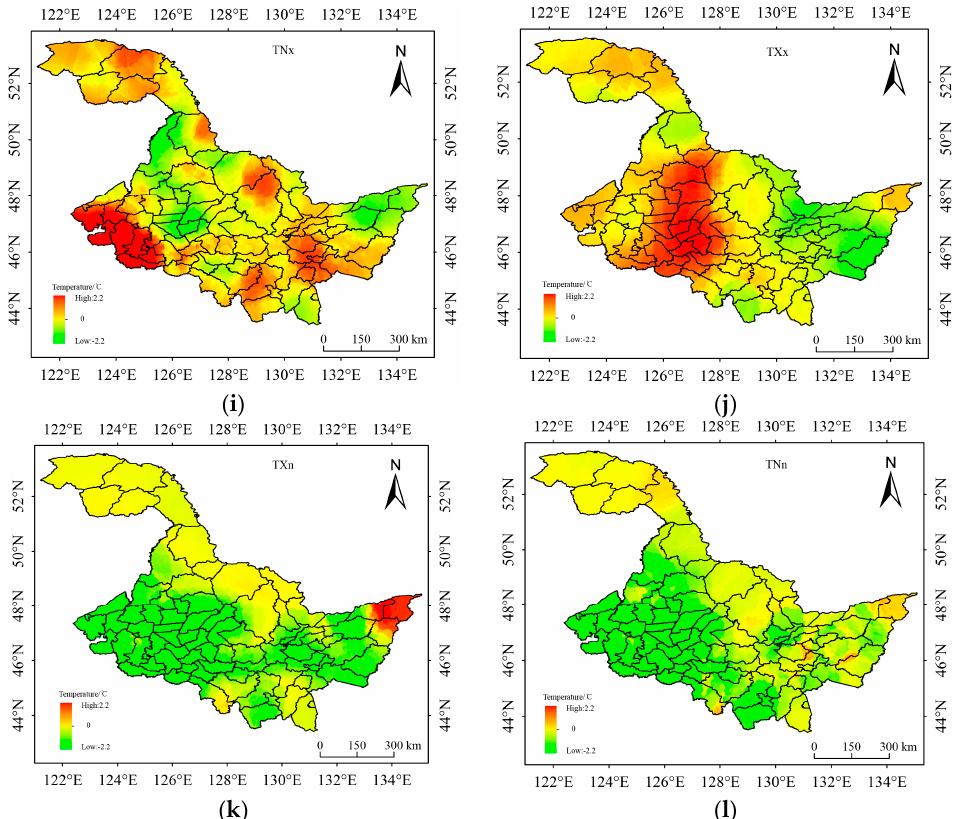
Figure 7. Maps showing the spatial distribution of extreme climatic indexes between the 1900s and 2010s in Heilongjiang Province. ( a ) Warm days; ( b ) Warm nights; ( c ) Tropical nights; ( d ) Summer days; ( e ) Cold days; ( f ) Cold nights; ( g ) Frost days; ( h ) Ice days; ( i ) Maximum value of daily minimum temperature; ( j ) Maximum value of daily maximum temperature; ( k ) Minimum value of daily maximum temperature; ( l ) Minimum value of daily minimum temperature. Table 2. Spatial correlation coefficients between forested area and extreme temperature indexes.